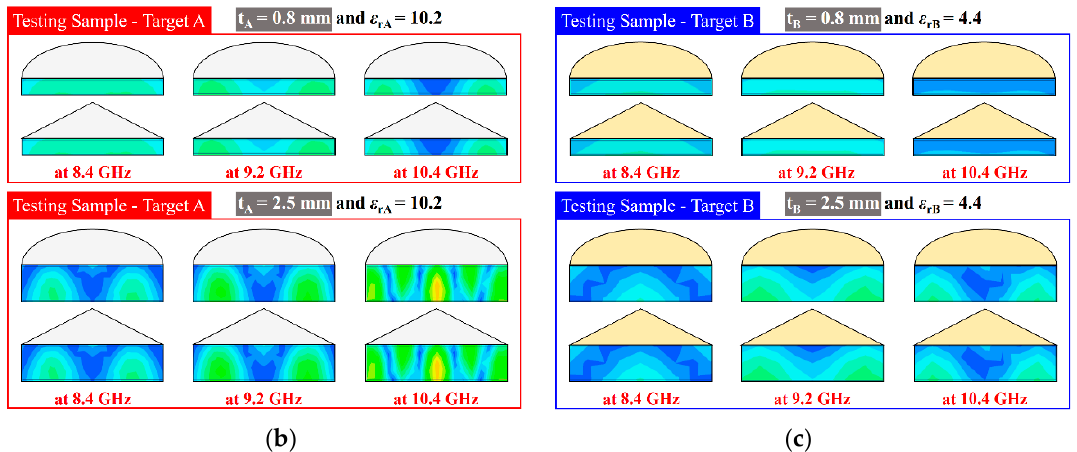
Figure 5. Simulated cross-sectional electric field distribution of the ( a ) waveguide antenna microwave imaging sensing system, ( b ) inside target A, and ( c ) inside target B. P 1 = 300 mm, H 1 = 300 mm, and H 2 = 109 mm.